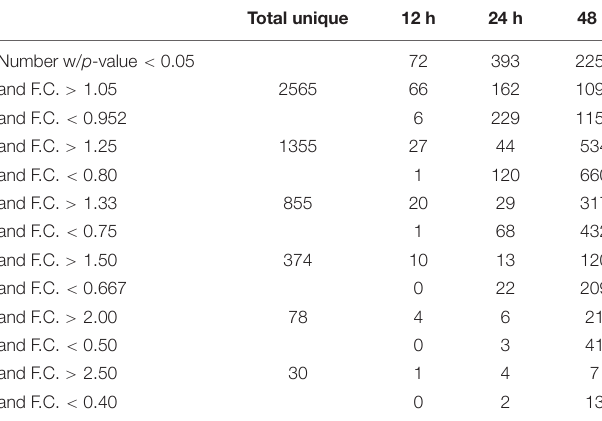
TABLE 1 | Numbers of ZIKV-induced significantly dysregulated